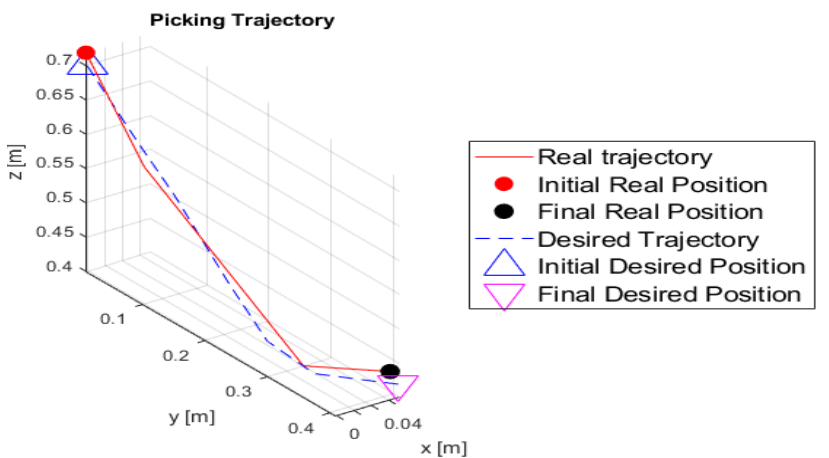
Figure 21. Real and desired trajectory of RM Cyton from initial to the ARS PeopleBot position, for picking up the work-piece from ARS PeopleBot using inverse kinematics control and eye in hand VSS for precision positioning.